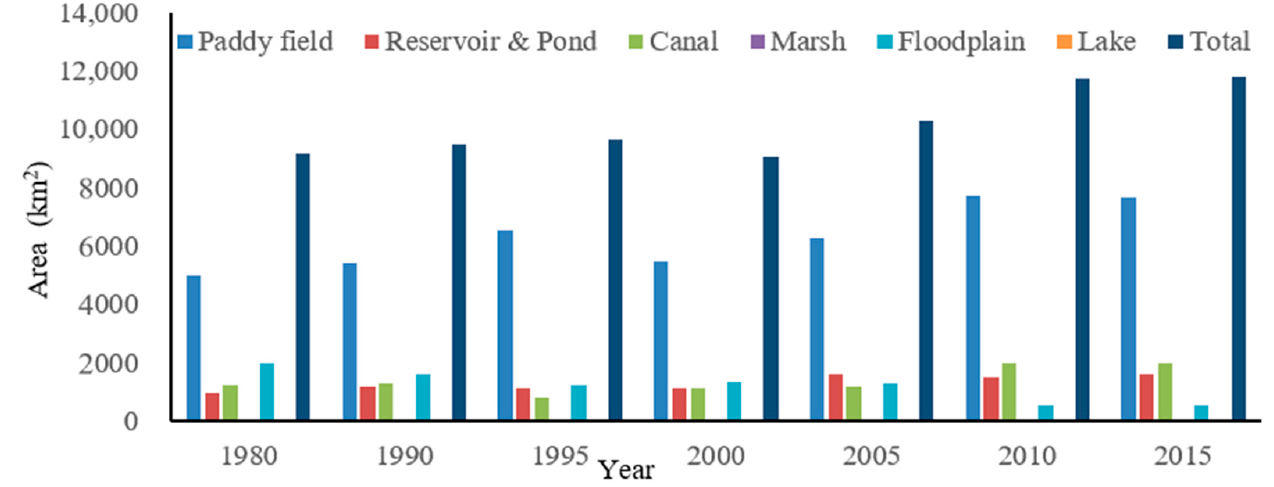
Figure 2. Change in areas of six wetland types from 1980–2015.